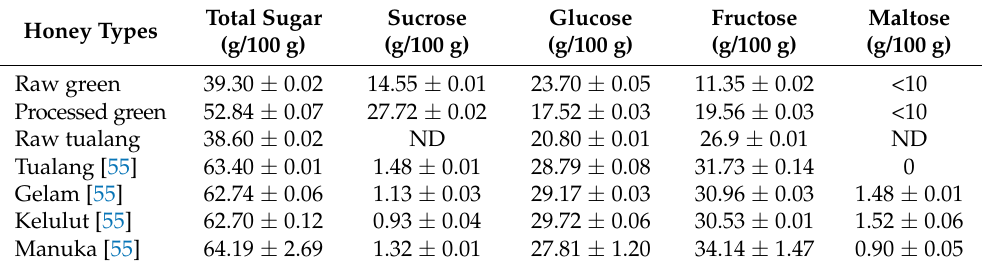
Table 2. Sugar analysis of green honey compared to common honey from various origins.